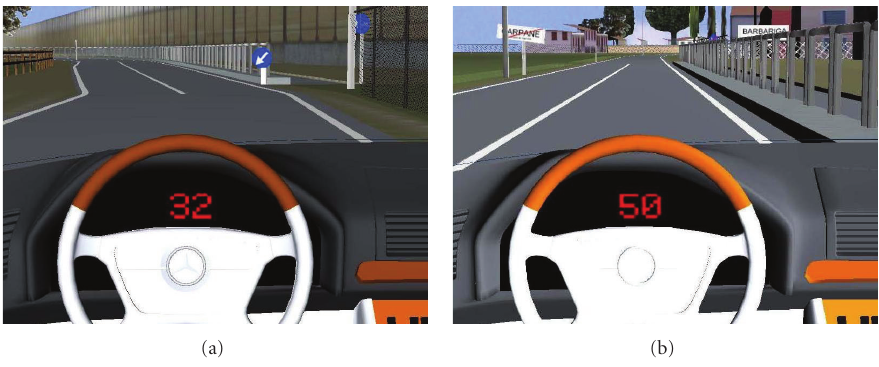
Figure 2: Details of the driving simulator.